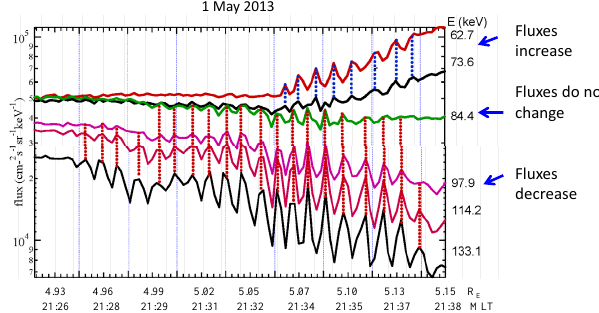
Figure 8. Distribution of energetic ion fluxes for the energies from 62.7 to 133.1keV versus geocentric radius with values from 4.92 to 5.15 R E